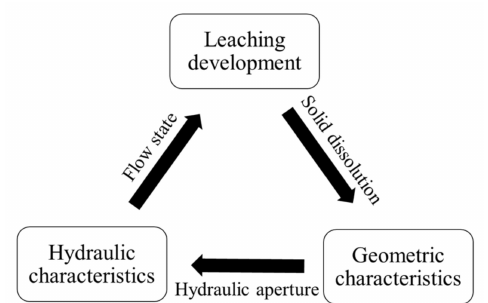
Figure 2. Coupling of the leaching, fracture geometry and hydraulic